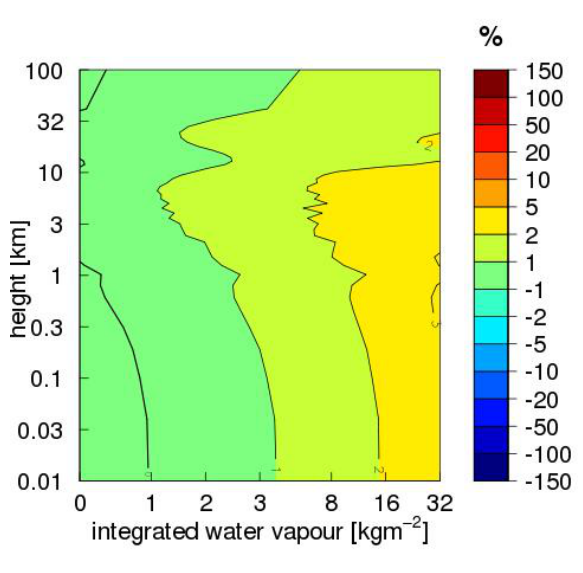
Figure 3. As for Fig. 2 but for hlradia compared to